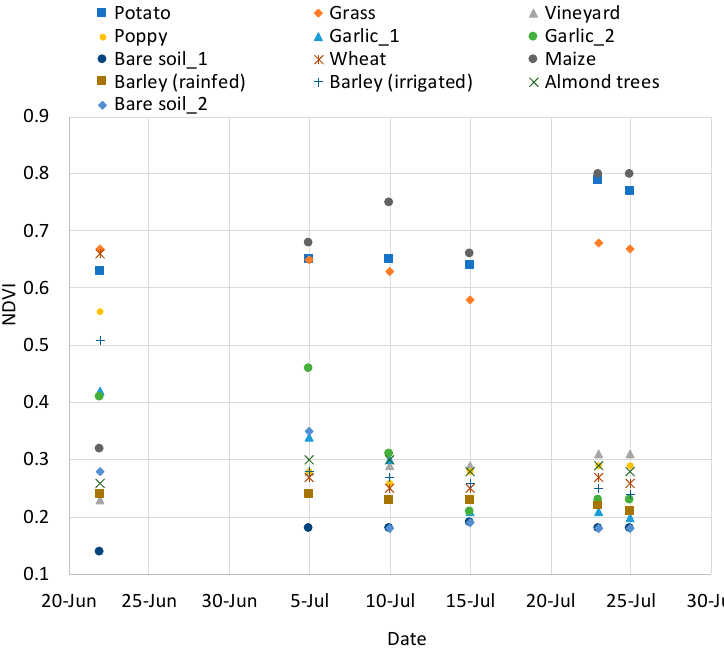
Figure 3. Distribution of the Sentinel-2 NDVI values for the different sites labeled in Figure 1, and the images/dates listed in Table 1.